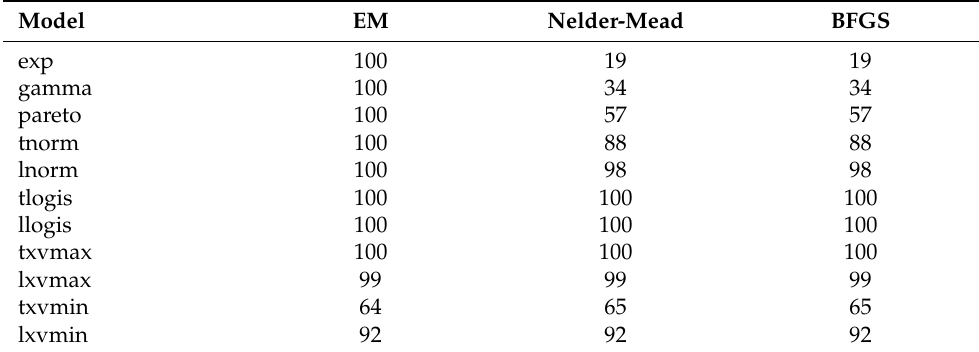
Table 2. The number of converged estimations (SS1A).